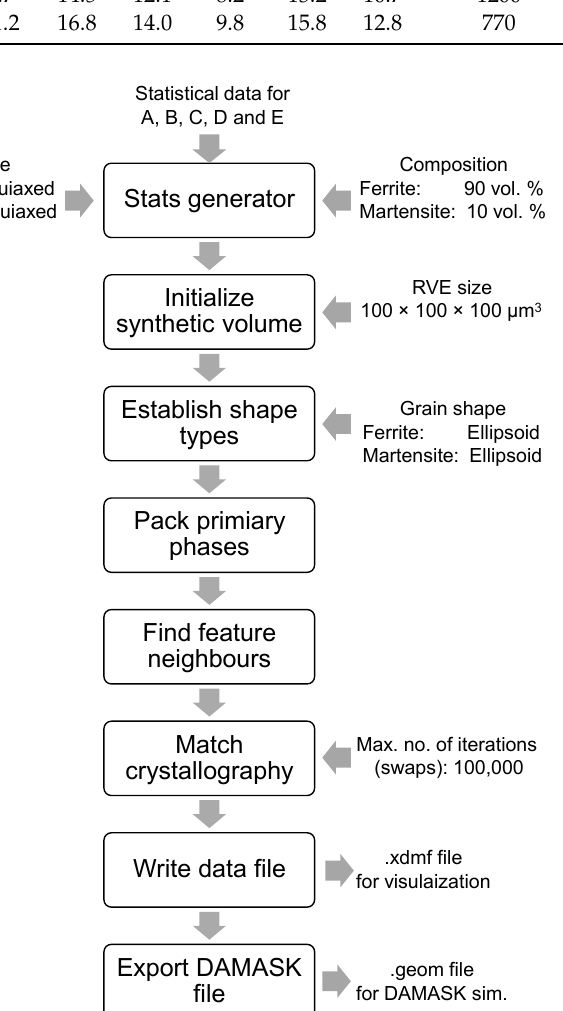
Figure 1. Block diagram of the DREAM-3D pipeline for RVE generation with associated inputs and outputs of various pipeline blocks. Table 1 provides details of statistical input data for A, B, C, D, and